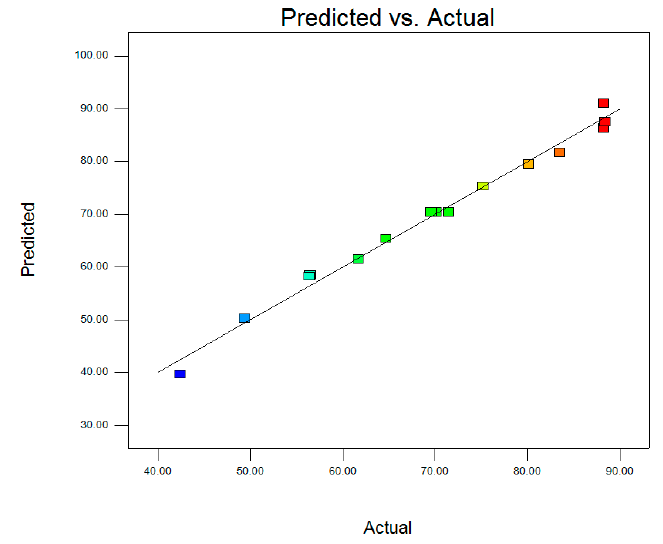
Figure 4. Comparison of the experimental data with those predicted by the response surface methodology (RSM) model.